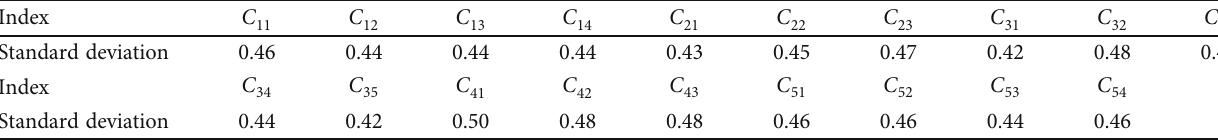
Table 16: Standard deviation between evaluation indexes.